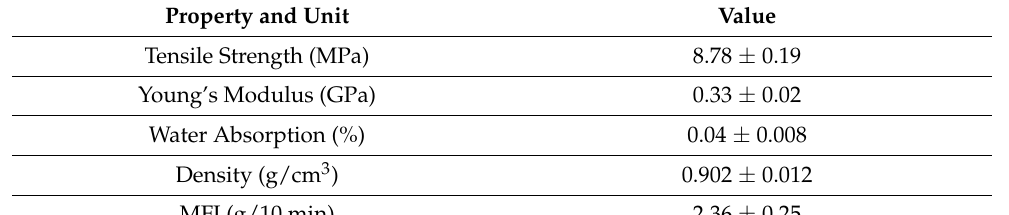
Table 1. Properties of the rLDPE.